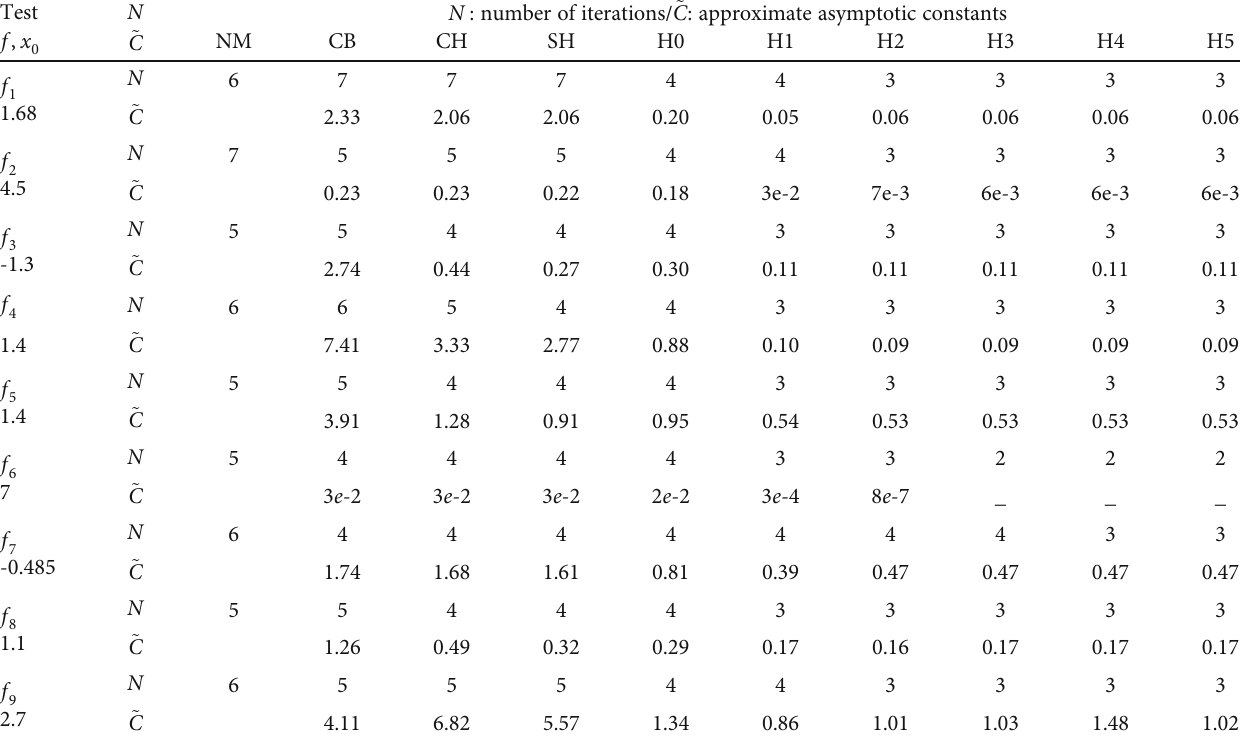
Table 3: Comparison with other third order methods.